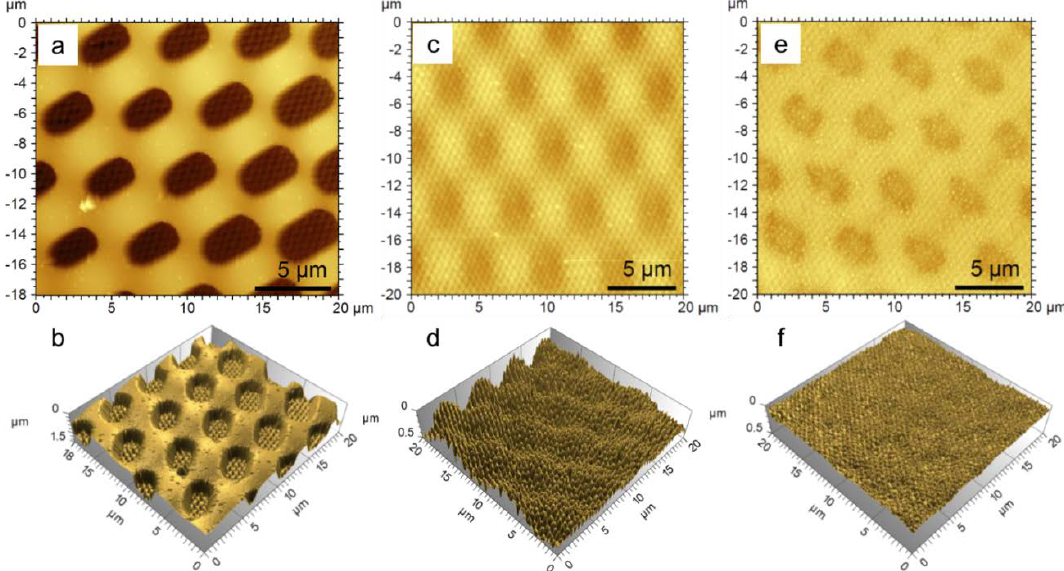
Figure 2. AFM pseudo-color images of ( a , b ) 5 µm on 0.5 µm hierarchical patterns (using two layers of resist), ( c , d ) 0.5 µm pattern on top of 5 µm pattern (also using two layers of resist) and ( e , f ) 5 µm and 0.5 µm hole-like patterns exposed in a single layer of SU-8